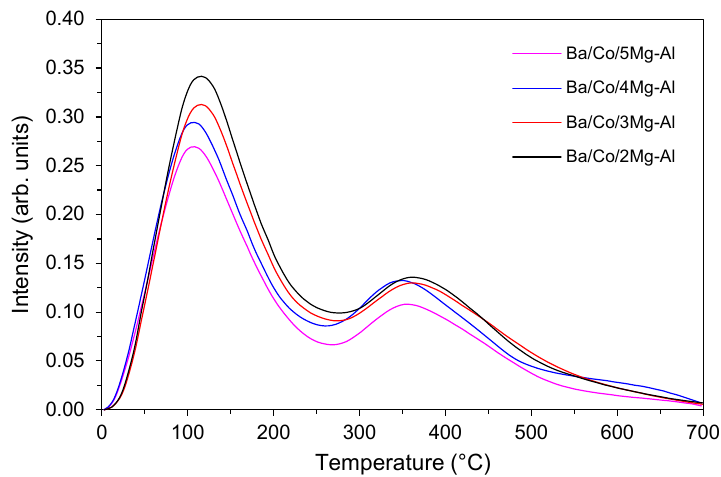
Figure 7. H 2 -TPD profiles of the Ba/Co/Mg-Al catalysts supported on mixed oxides with various Mg/Al molar ratios.